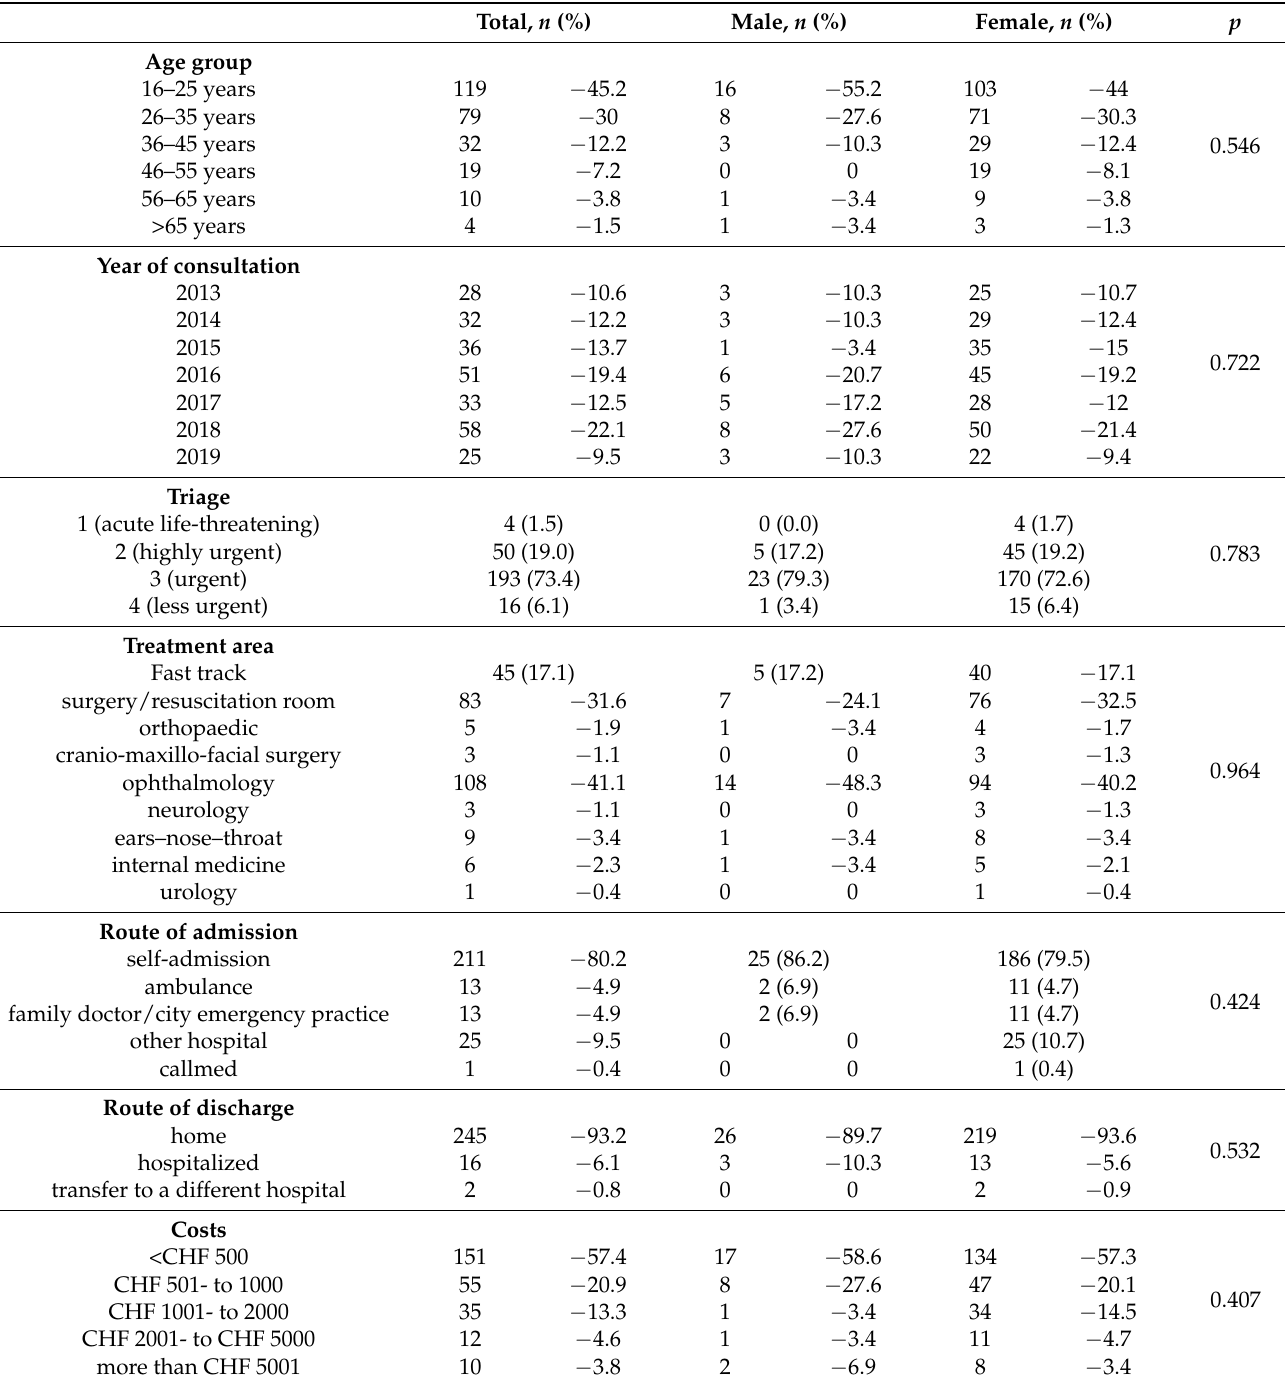
Table 1. Characteristics of all patients presenting to the emergency with 263 floorball-related accidents according to sex